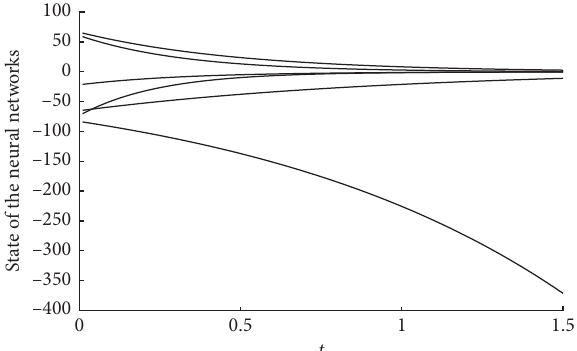
Figure 3: The state response of neural networks (5) without any controller in Theorem